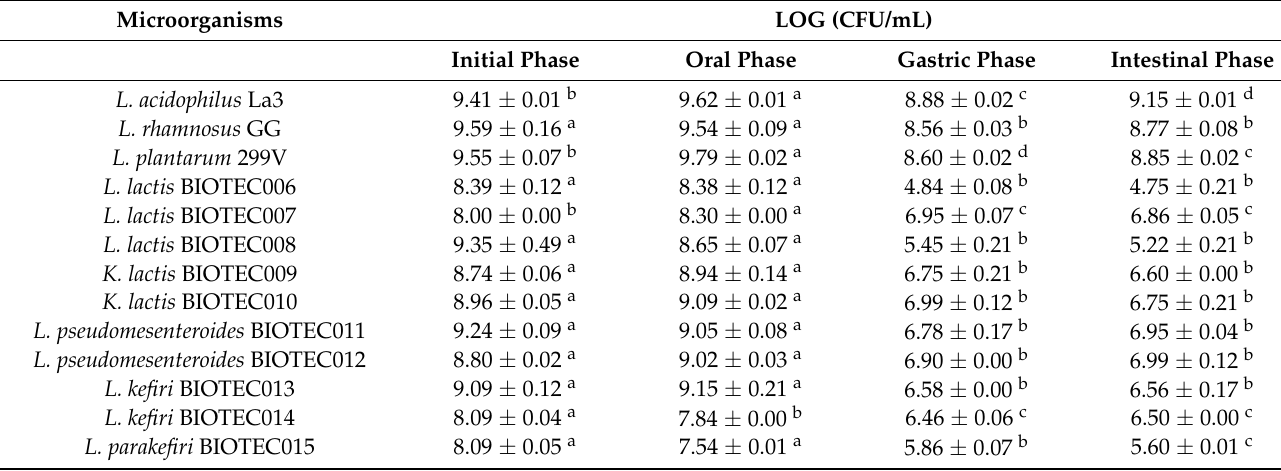
Table 6. Survival of individual kefir isolates and commercial probiotics to in vitro gastrointestinal digestion simulation a .